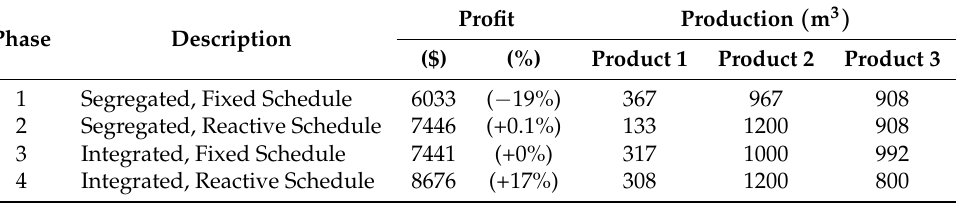
Table 8. Results: Scenario